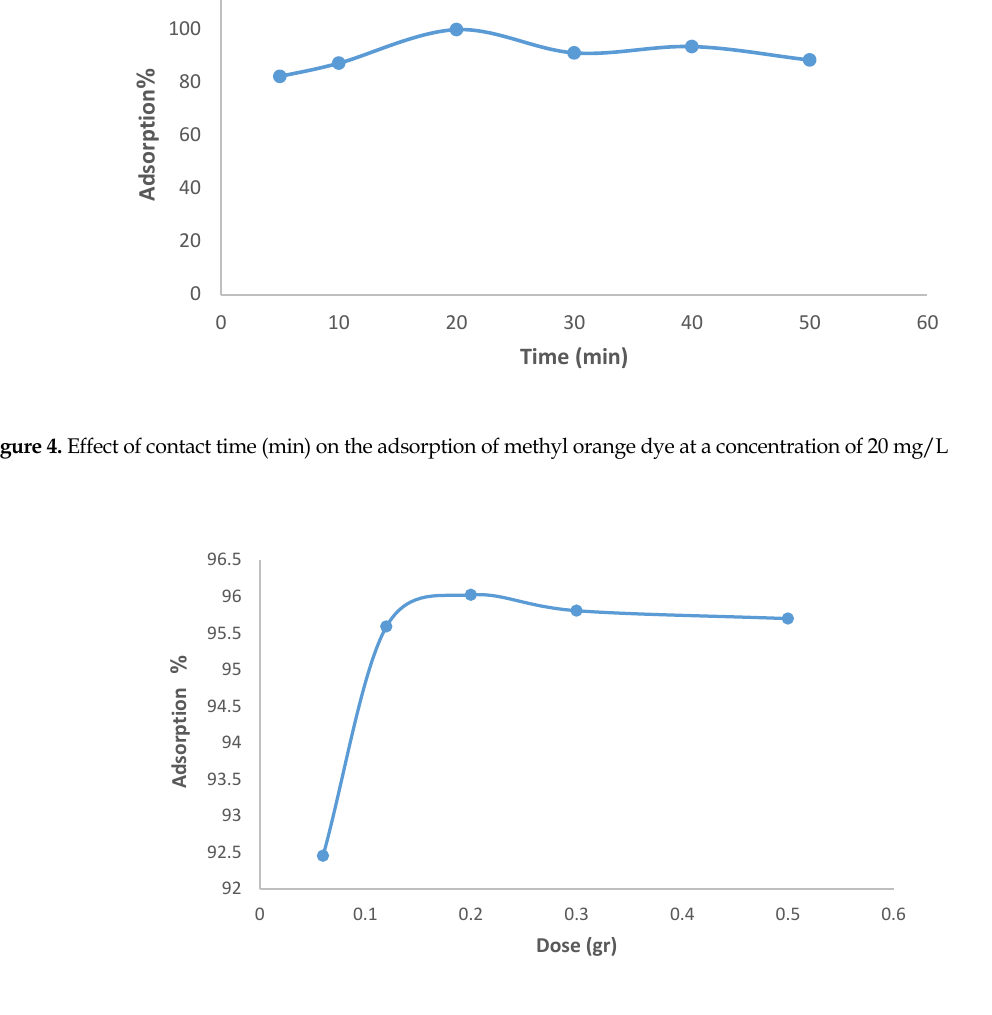
Effect of contact time